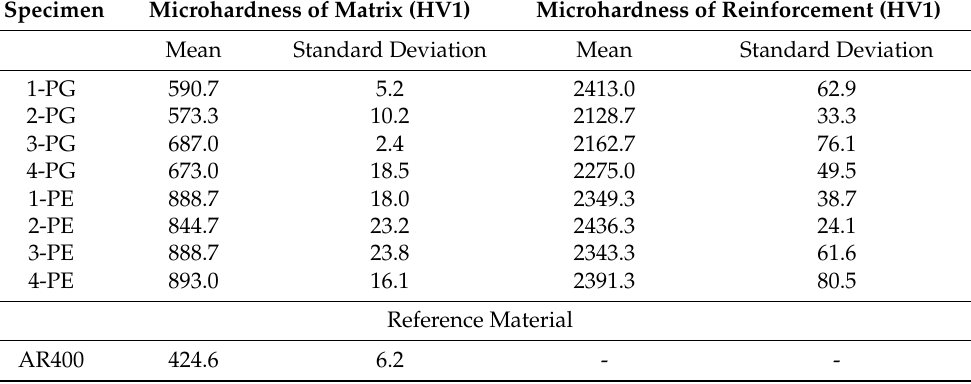
wear-resistant steel,